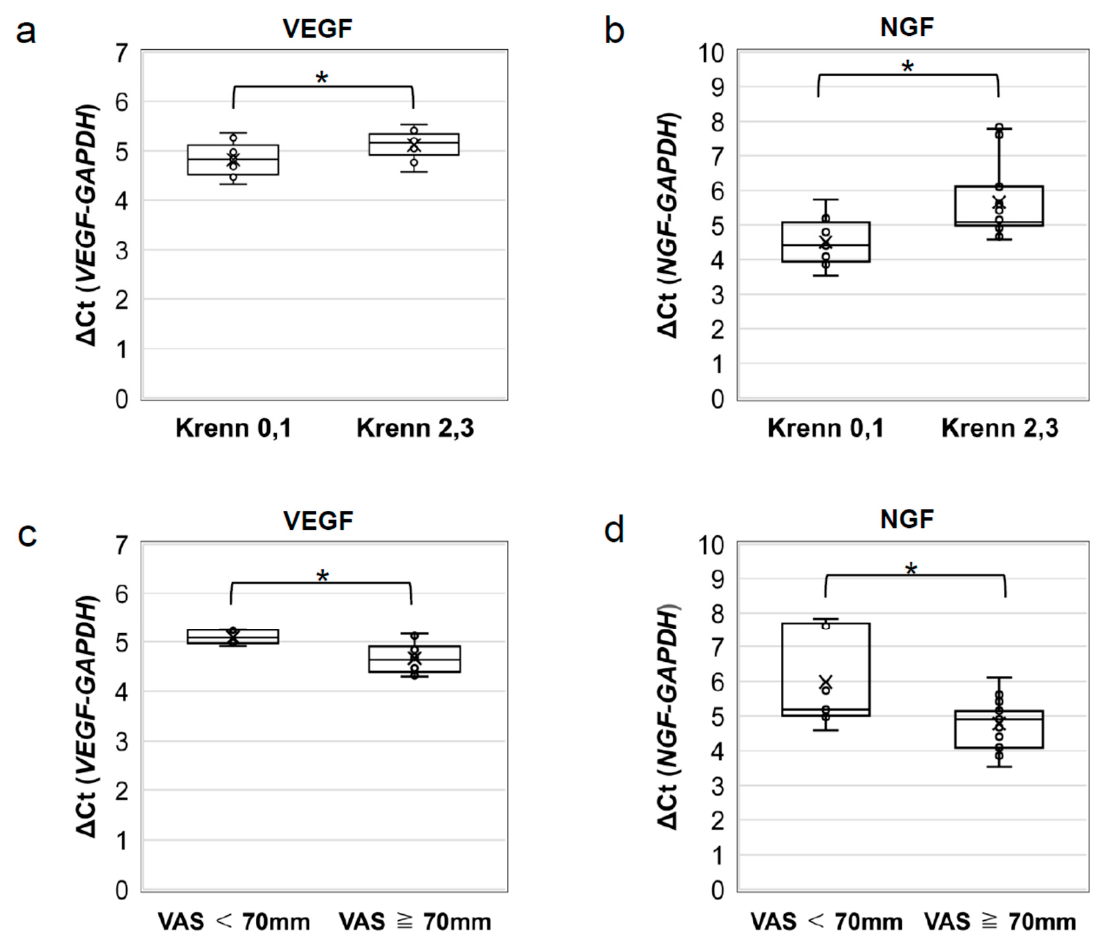
Figure 6. RT-PCR analysis of VEGF and NGF mRNA expression. Comparison of the ∆ Ct of ( a ) VEGF and ( b ) NGF mRNA expression between patients with mild (Krenn score 0 or 1) and severe (Krenn score 2 or 3) degeneration. VEGF and NGF mRNA expression was found to be lower in the group with severe acetabular labral degeneration. Comparison of ∆ Ct of ( c ) VEGF and ( d ) NGF mRNA expression between patients with mild or moderate pain (VAS < 70 mm) and severe pain (VAS ≥ 70 mm). VEGF and NGF mRNA expression was higher in the group in which patients reported severe pain. * p < 0.05. GAPDH, glyceraldehyde-3-phosphate dehydrogenase; NGF, nerve growth factor; VAS, visual analogue scale; VEGF, vascular endothelial growth factor.